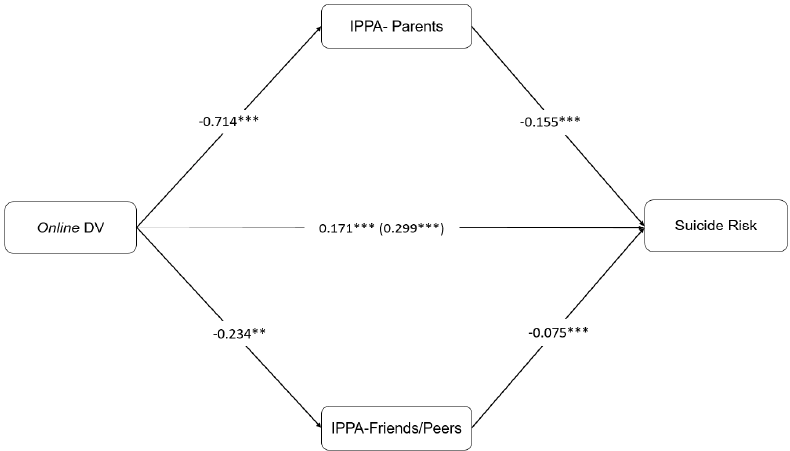
Figure 1. Model 1 with IPPA–P and IPPA–F as a Mediation in the Effect of Offline DV on Suicide Risk.